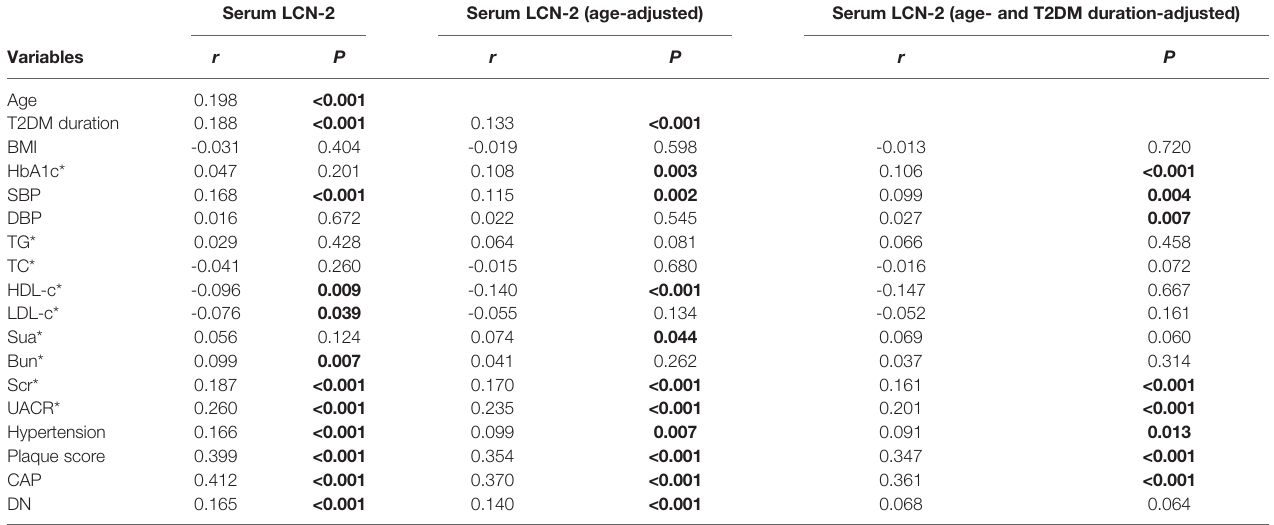
TABLE 3 | Partial correlation of serum LCN-2 with other risk factors of DN and CAP. Serum LCN-2 Serum LCN-2